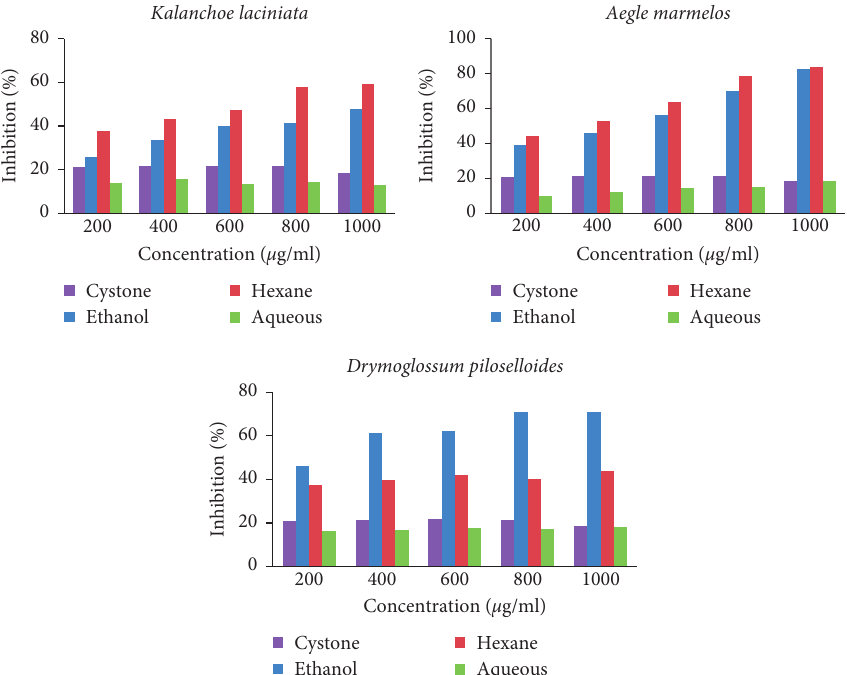
Figure 3: Percentage of inhibition of different extracts of plants on calcium oxalate nucleation. Each graph shows the dose response effect of each plant extracted in ethanol, hexane, and water against the standard drug, Cystone. Except for the aqueous extract of Aegle marmelos (AEAM) and aqueous extract of Drymoglossum piloselloides (AEDP) at the highest concentration of 1000 μ g/mL, all other extracts at all concentrations showed a significant difference in inhibition ( p < 0.05) compared to the standard drug,